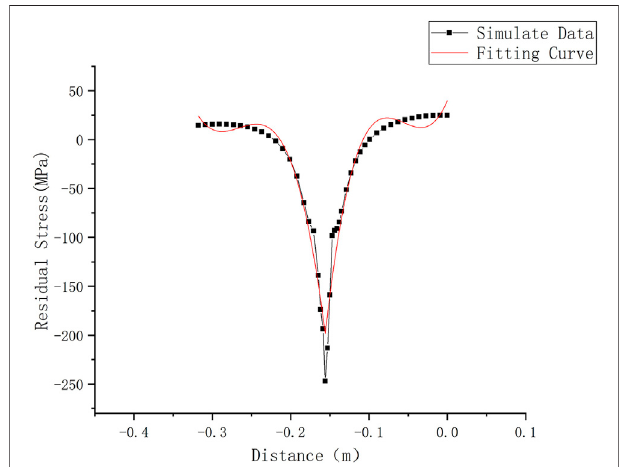
FIGURE13 | Fitting curve of residual stress σ x